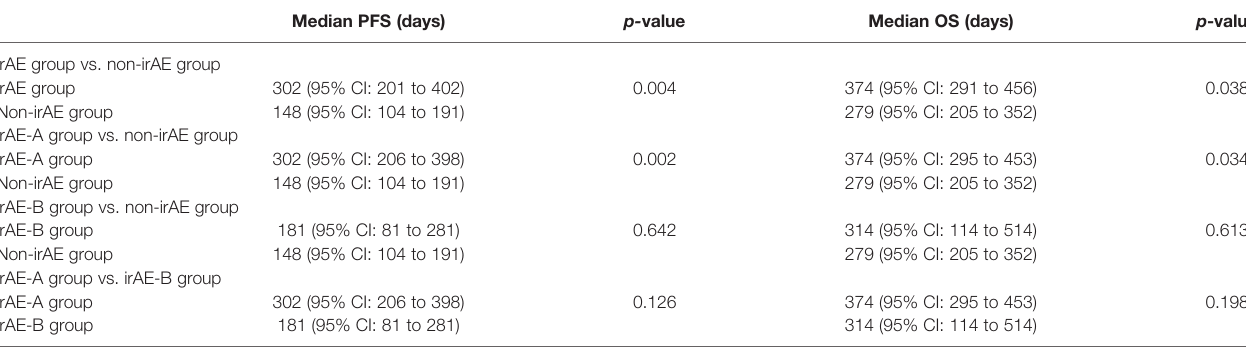
TABLE 3 | Kaplan – Meier survival curve of progression-free survival (PFS) and overall survival (OS). Median PFS (days) p- value Median OS (days) p -value